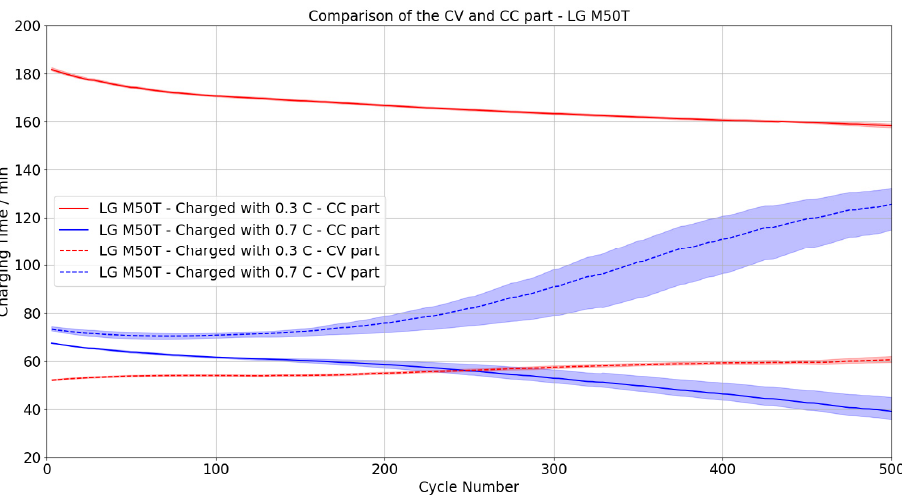
Figure 11. Development of the charging time during the cycle test. Separation of the CC and CV part for LG M50T.